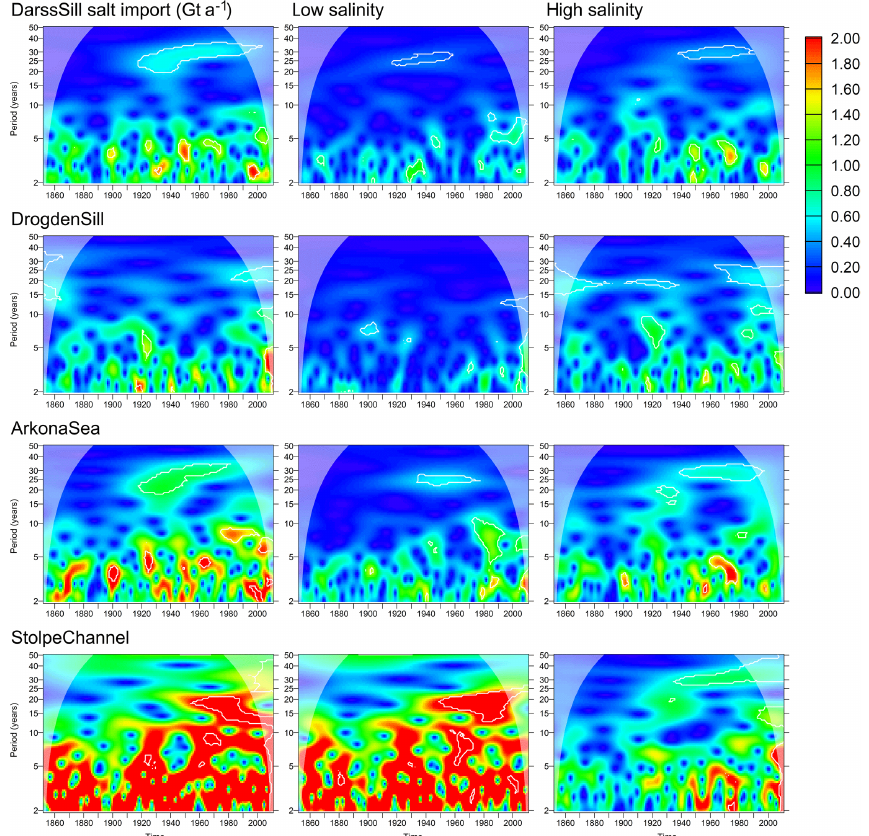
(transport in all salinities above ˆ S ). Middle S,t in